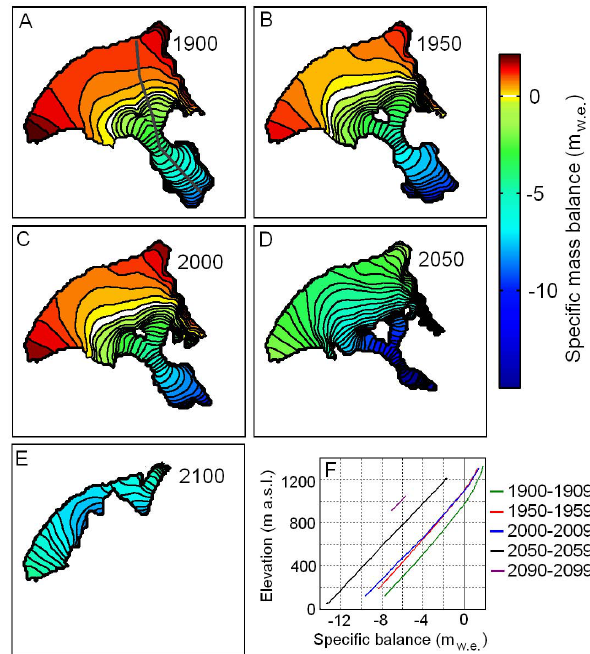
Fig. 12. (A–E) The modeled surface mass balance at 50yr intervals computed with method MI and the DMI HIRHAM ECHAM5 cli- mate scenario (shown with bold line in Fig. 9). The average mod- eled surface mass balance for 10yr periods corresponding to the first decade of each 50yr interval is plotted as a function of eleva- tion in (F) (location of the profile is shown in (A)